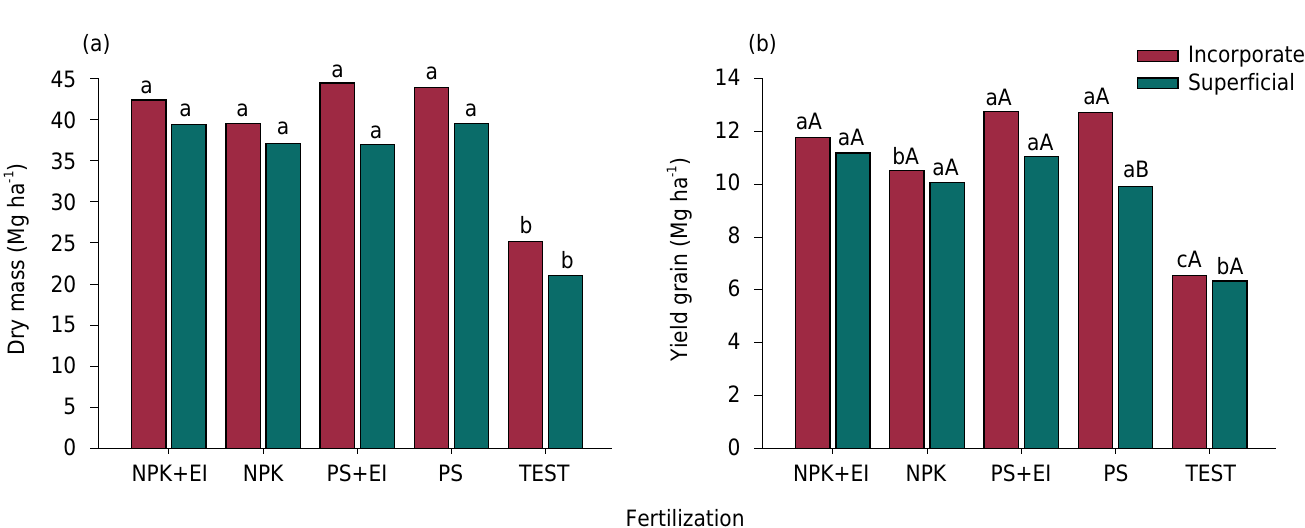
Figure 1. Yield of aerial part dry mass (a) and grains (b) of corn in the second and third crops in a Cambissolo Húmico Álico (Humic Cambisol) under fertilization with mineral fertilizer (NPK), mineral fertilizer plus enzyme inhibitors (NPK+EI), pig slurry (PS), pig slurry plus enzyme inhibitors (PS+EI), and control without fertilization (TEST), in application on soil surface and incorporated. Columns with the same lowercase letters among fertilizations within each application form and with same uppercase letters between application forms within each fertilization do not differ among themselves by the Tukey test (p<0.05).